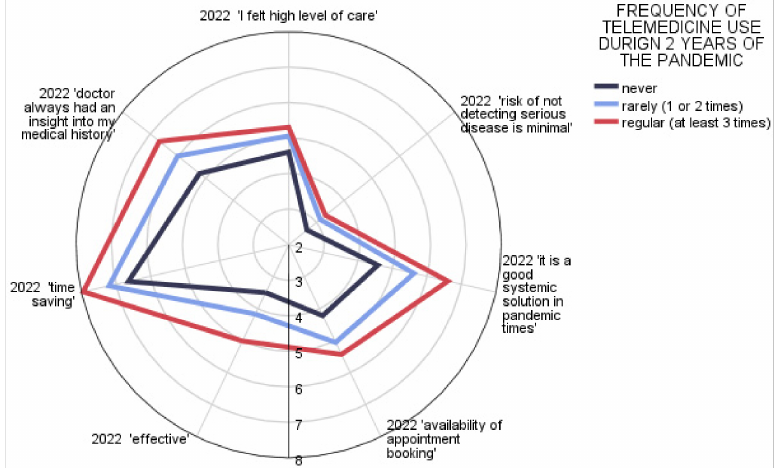
Figure 4. Patient opinion on telemedicine after year 2 of the pandemic